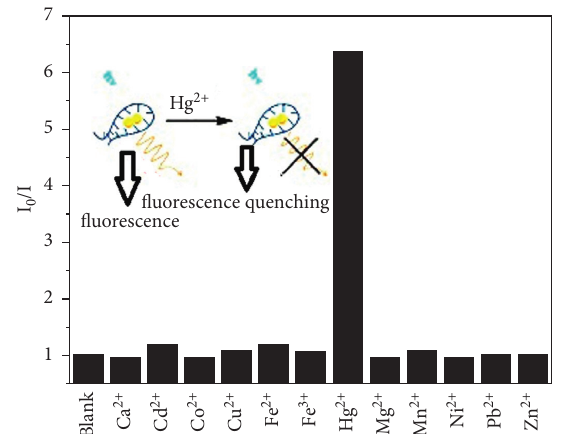
Figure 7: Fluorescence extinction mechanism for high-sensitivity Hg 2 + detection